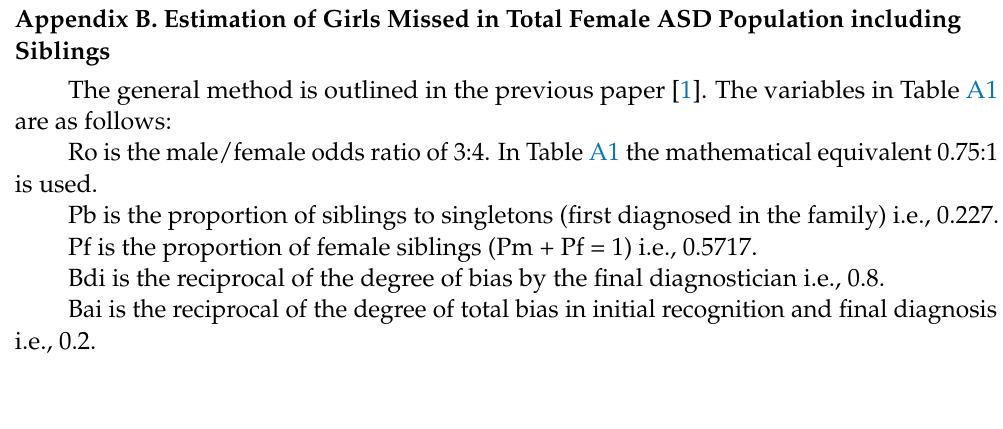
Table A1. The relative proportions of all children with ASD in the population of interest.